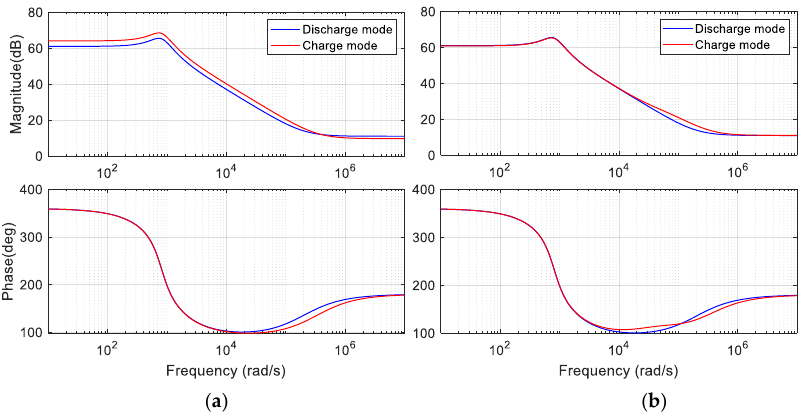
Figure 14. Bode plots of duty ratio-to-output voltage (𝑣 2 ), 𝐺 11 (𝑠). ( a ) Uncompensated charge mode; ( b ) compensated charge mode. ( b ) compensated charge mode.